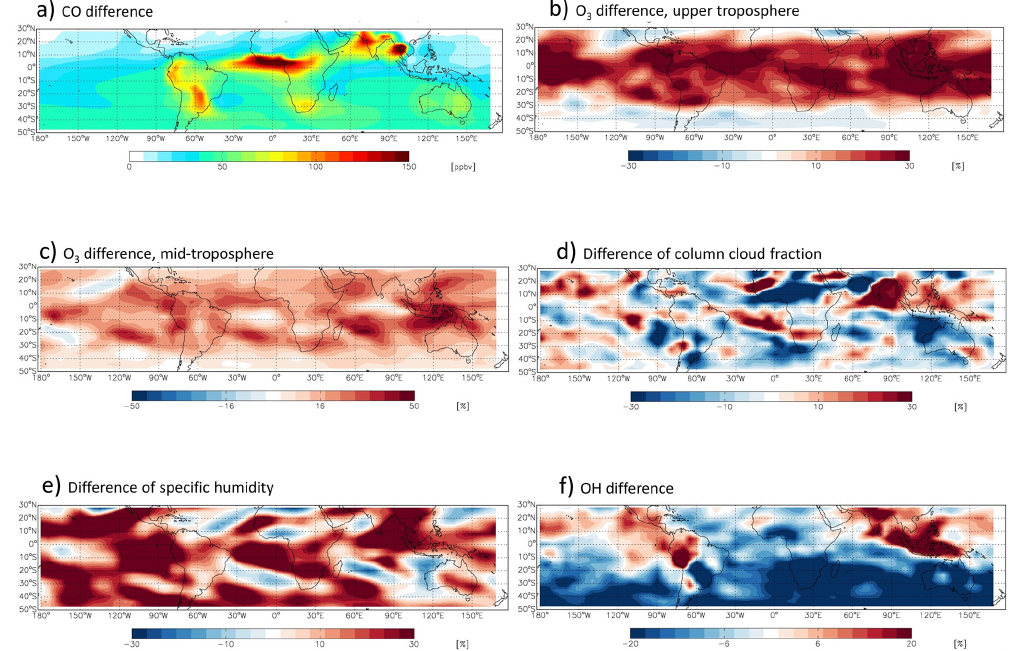
Figure 7. Difference plot (2050s–2000s) of lower tropospheric CO distribution (ppb) over northern Africa coast and Atlantic Ocean in January (a) . Percentage difference (2050s–2000s) of O 3 distribution in upper troposphere (7.6–12.8km) (b) , and mid-troposphere (2.1–